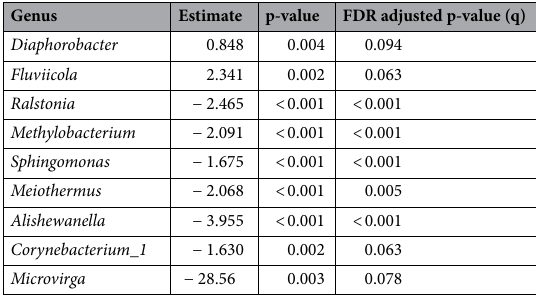
Table 2. Microbial genera associated with mortality.